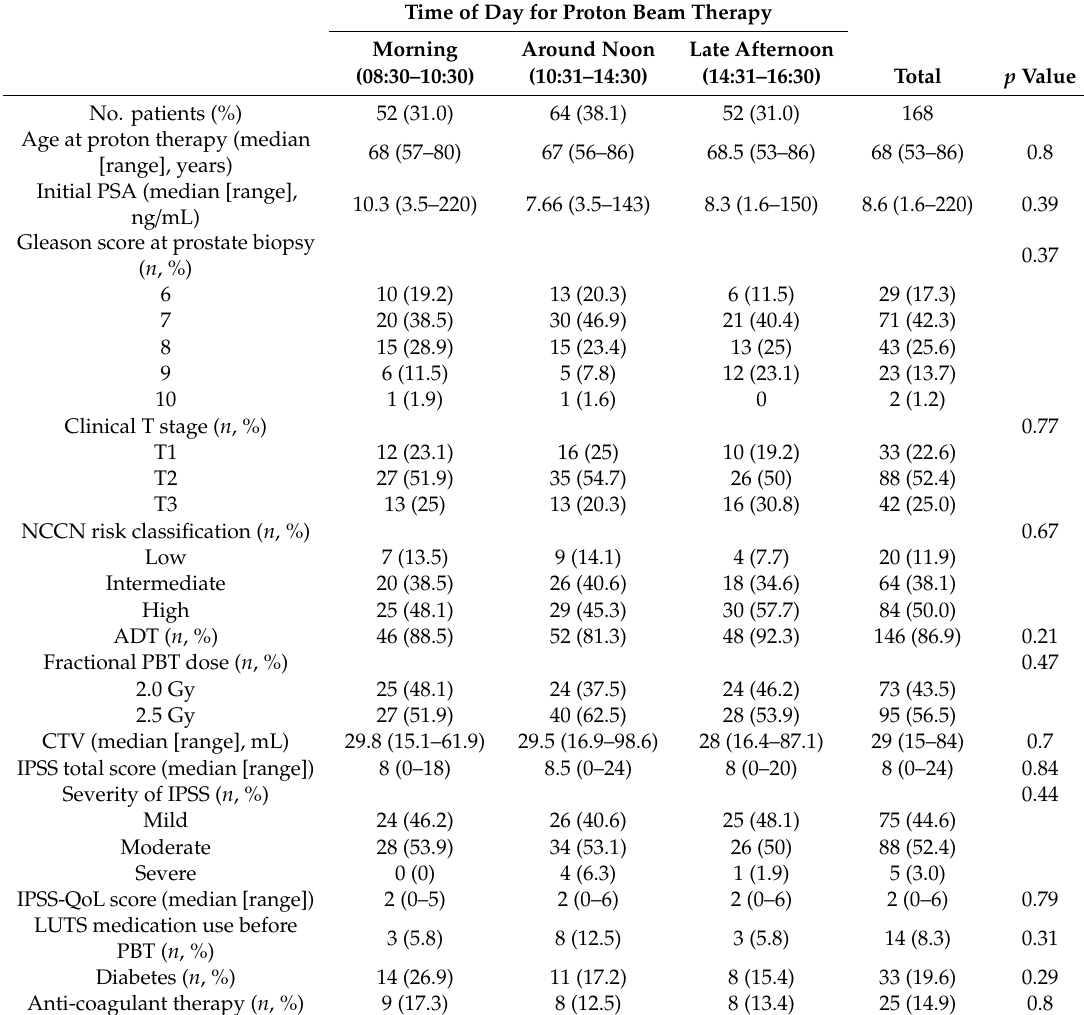
Table 1. Characteristics of the 168 patients who received proton beam therapy for localized prostate cancer. Time of Day for Proton Beam